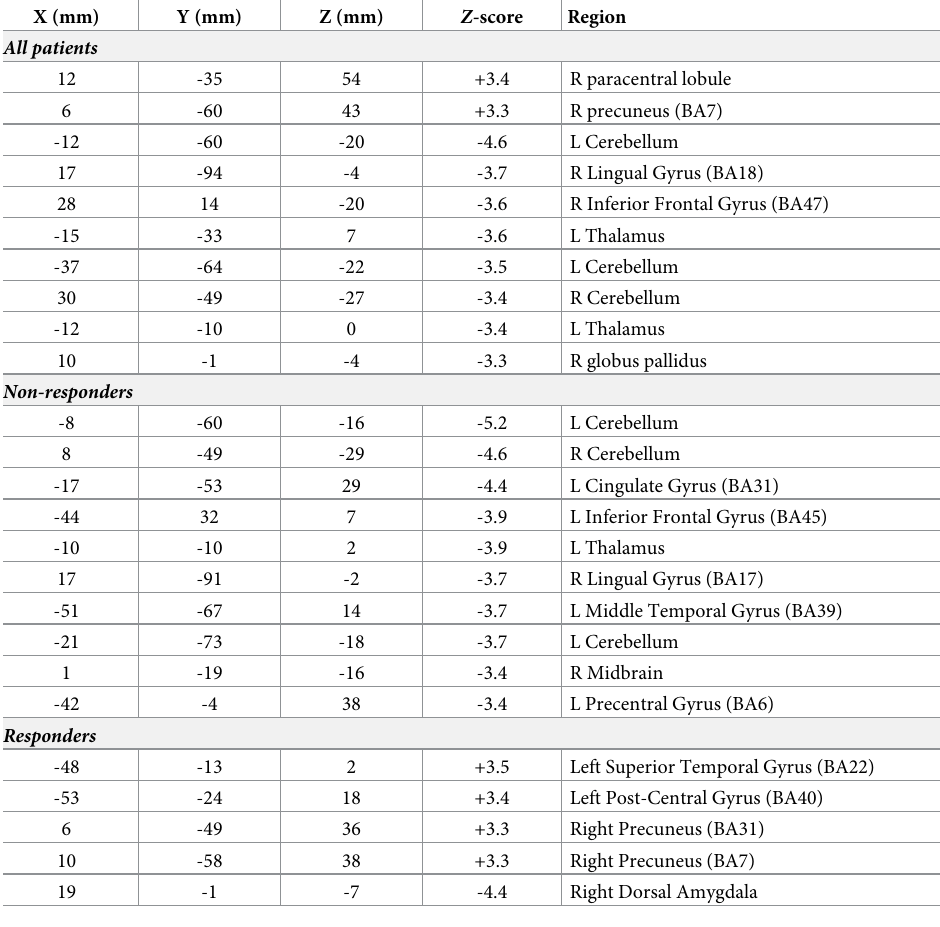
Table 2. Significant changes in whole-brain voxelwise